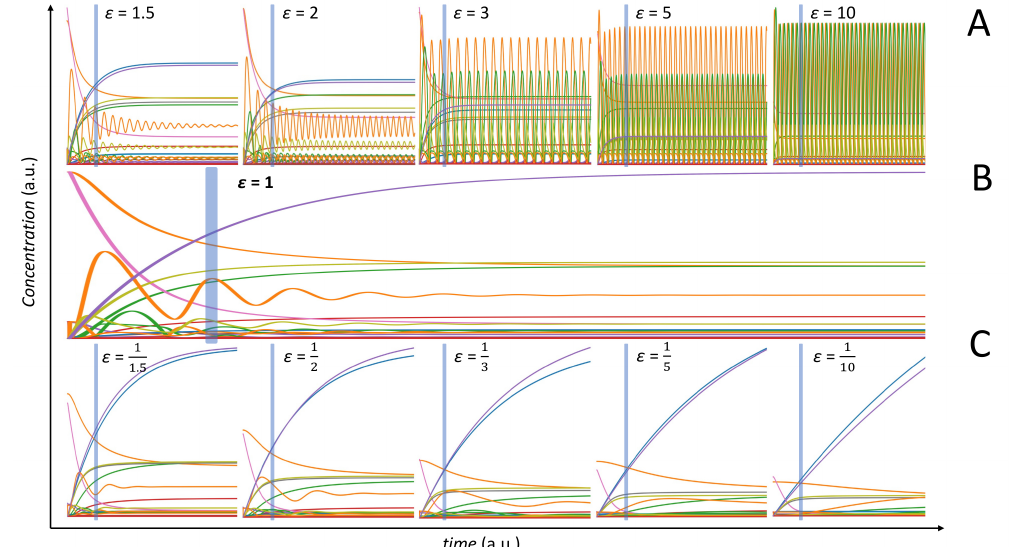
Figure 6. Behaviour of the NF- κ B dynamic model. ( A ) Time concentration profiles for model perturbation with (cid:101) > 1. ( B ) Original model. ( C ) Time concentration profiles for model perturbation with (cid:101) < 1. Different colours correspond to different metabolite time profiles. The vertical lines indicate the time sampling